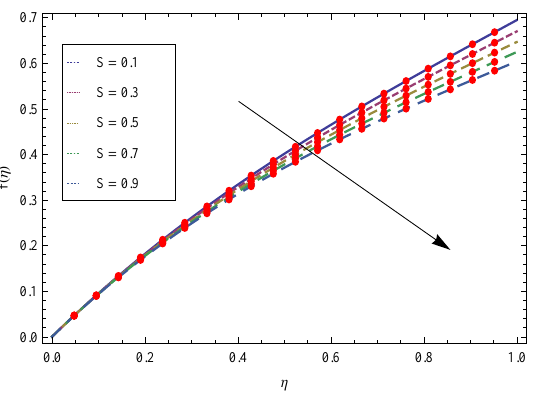
Figure 4. The comparison between HAM and numerical solutions for concentration profile φ ( η ) , when h = − 0.6, λ = 0.2, S = 0.2,kr = 0.2,Pr = 1,Ec = 0.6,Nb = 1,Nt = 0.1, β = 1 and Sc = 0.5.